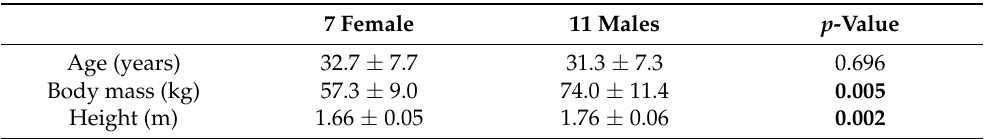
Table 1. Age and anthropometrical features of enrolled participants (mean ± standard deviation). The p -value is the outcome of the unpaired t -test comparing the effect of the factor gender on the independent variables. The p -values are highlighted in bold when reaching significance ( p < 0.05).